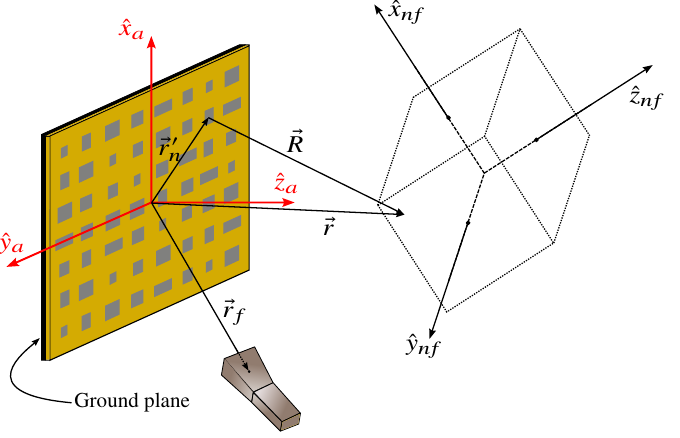
Figure 1. Sketch of the reflectarray configuration for general near-field synthesis based on the optimization of the near-field figures of